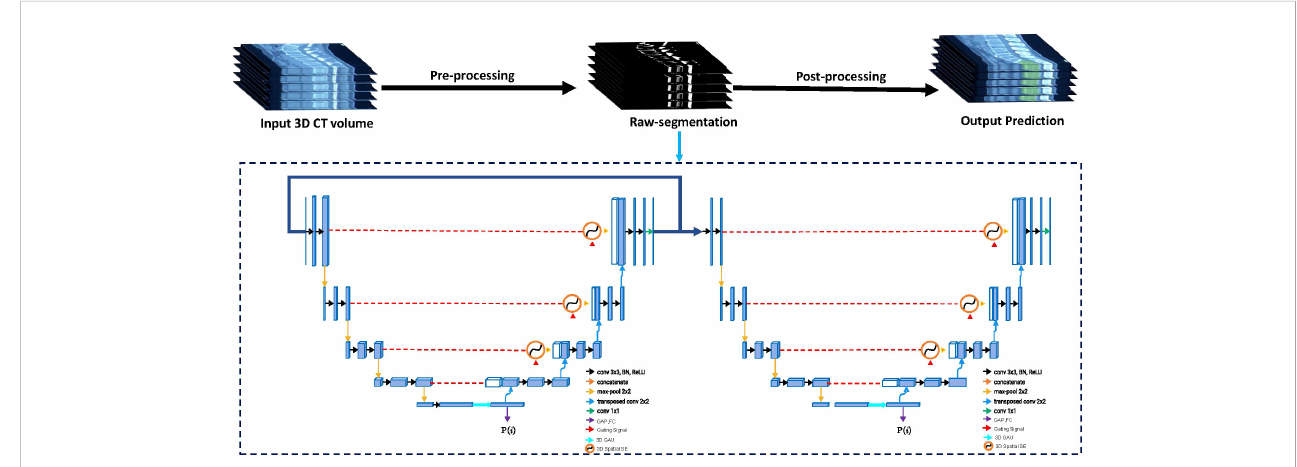
FIGURE 2 The fl owchart of the proposed Cascaded 3D-Unet network. The network structure is divided into two parts: encoder and decoder. Between the encoder and decoder, we used the three-dimensional (3D) spatial squeeze and excitation modules (3D Spatial SE) and 3D global attention-up sample modules (3D GAU) to replace the original skip connections used in 3D